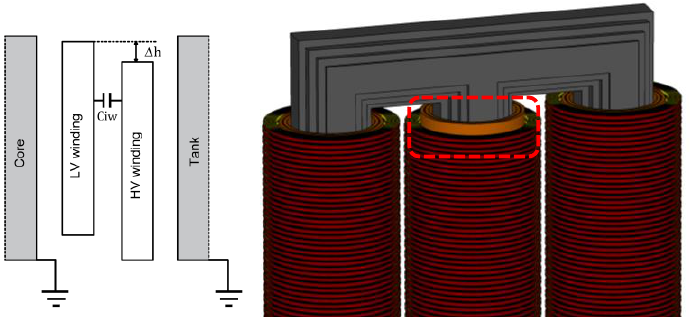
Figure 15. Representation of the axial displacement fault (ADF); schematic ( left ); B-phase HV winding of 3D HF model ( right ).